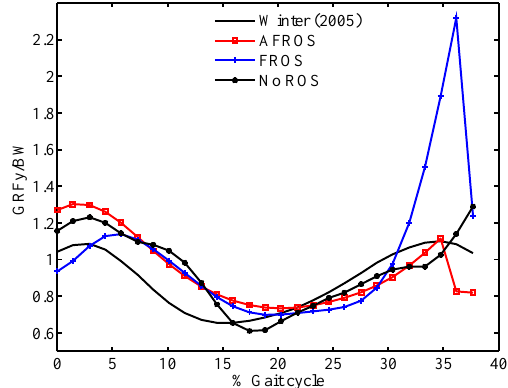
Figure 13. GRFx results for SS phase – experimental data and re- sults using AFROS and FROS foot models. (Gait cycle starts at toe- off of the other leg, that is, at the beginning of SS.)